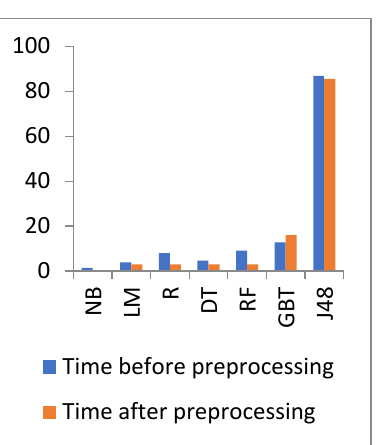
Figure 7. Time comparison of different algorithms on heart disease before and after preprocessing.